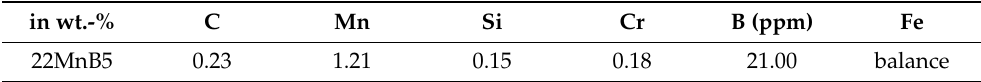
Table 1. Chemical composition of the used 22MnB5 steel in wt.-%.